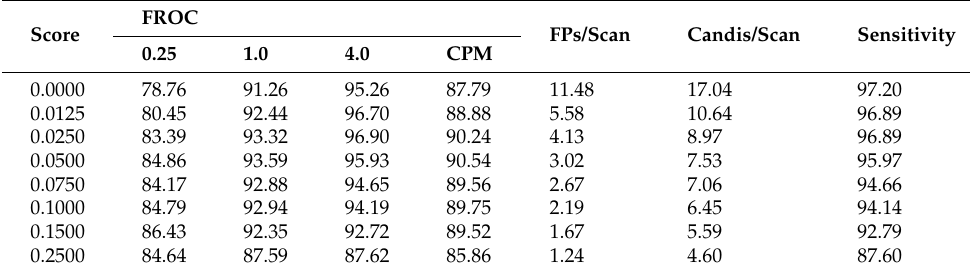
Table 4. Comparison of the FROC values and LUNA16 CAD Analysis of the TSND with the CS-Net using different candidate scores on the validation